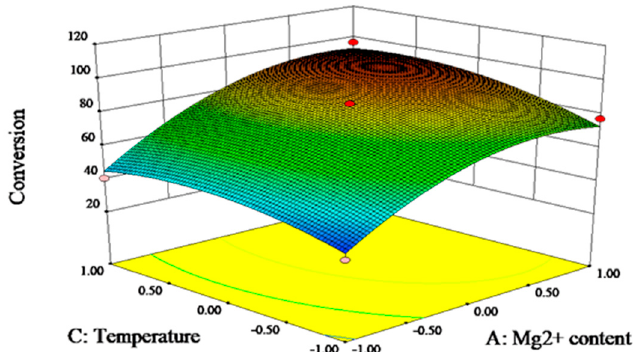
Figure 12. Temperature and magnesium ion concentration affect the conversion efficiency of enzyme catalytic reactions. For the temperature axis, “ − 1–1” represents temperatures from 15 ◦ C to 45 ◦ C. For the Mg 2+ content axis, “ − 1–1” represents Mg 2+ content from 1 mM to 10 mM.